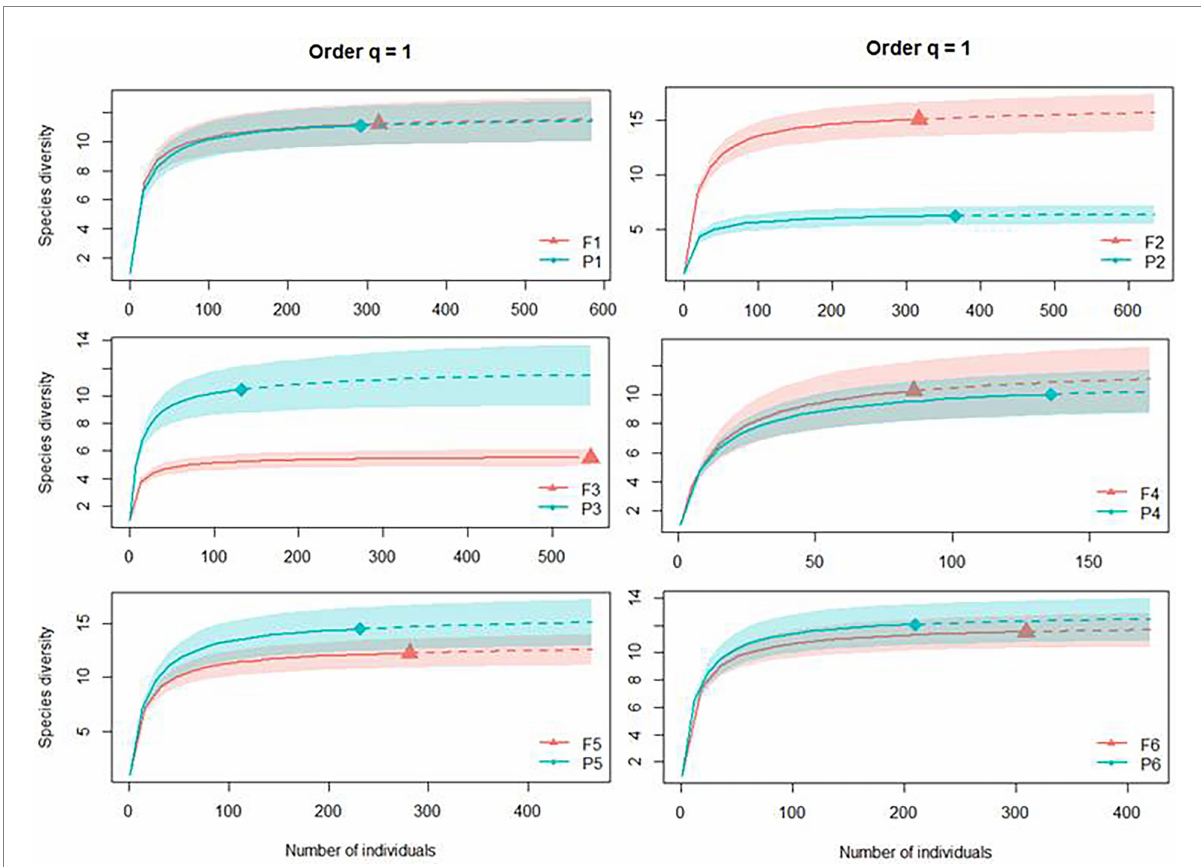
FIGURE 4 Individual-based rarefaction (solid lines) and extrapolation (dashed lines, up to double the sample size) of Dung beetle diversity for Hill numbers (q = 1) for each site, where F represents native forests and P represents Pinus